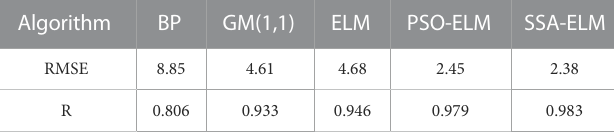
TABLE 3 Performance comparison of fi ve